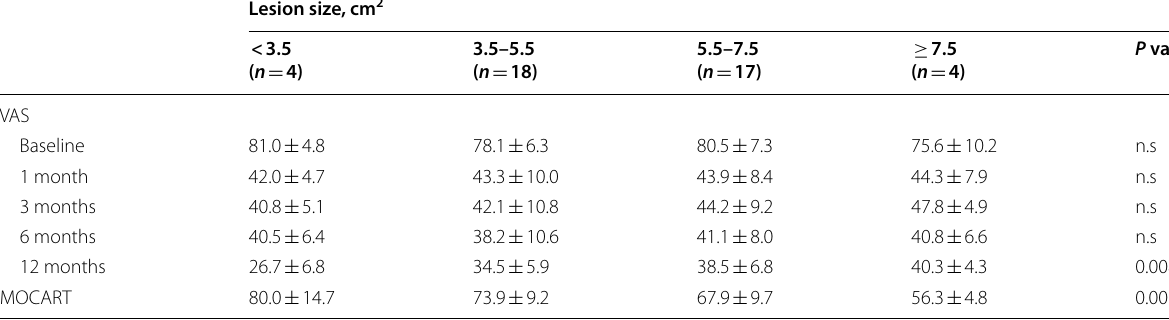
Data are presented as means standard deviation ± MOCART Magnetic resonance observation of cartilage repair tissue, VAS Visual analogue scale * Kruskal–Wallis test